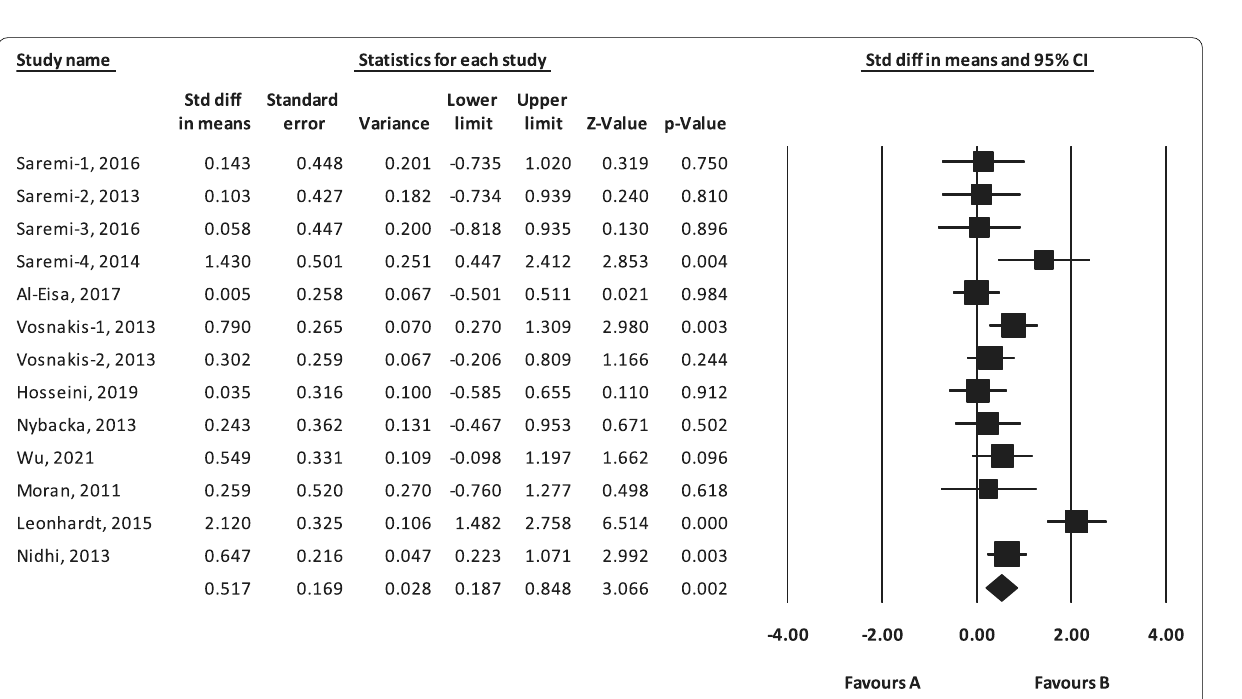
Fig. 3 Forest plot of studies included (RCTs and non-RCTs) in the meta-analysis before and after the intervention of the control group and the intervention